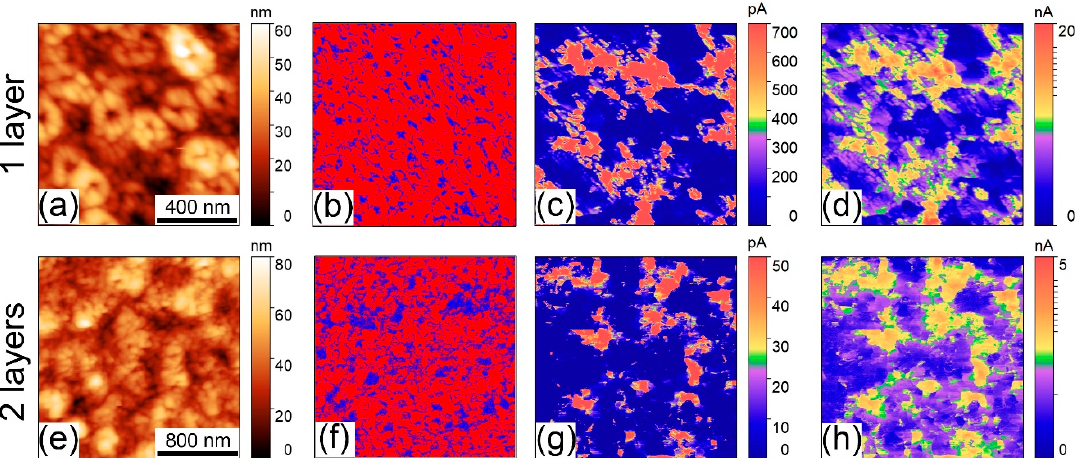
Figure 4. C-AFM measurements of the leakage current in ( a – d ) one-layer; ( b – h ) two-layer HTD BFO